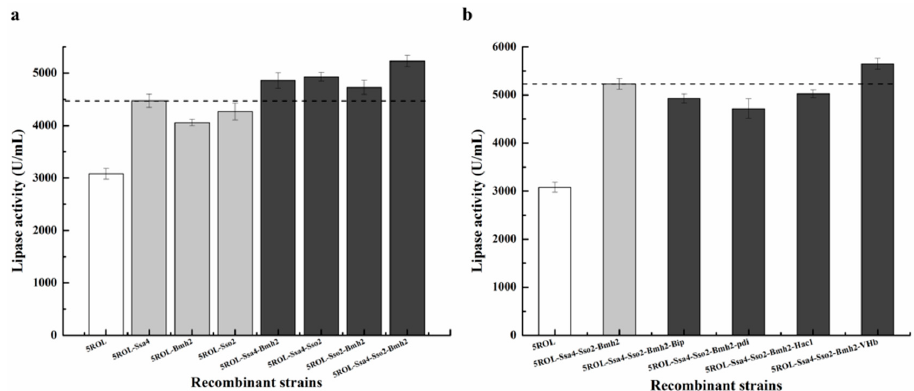
Figure 3. Cultivation properties of the recombinant strains in shaking flasks. ( a ) Effect of co-expressing multiple trafficking-related genes on ROL production in the strain GS115/pAO α -5ROL 11#. The dotted line indicates the lipase activity of the strain GS115/5ROL-Ssa4 12#. ( b ) Effect of co-expressing the helper proteins Bip, Pdi, Hac1, and VHb on ROL production in the strain GS115/5ROL-Ssa4-Sso2-Bmh2 4#. The dotted line indicates the lipase activity of the strain GS115/5ROL-Ssa4-Sso2-Bmh2 4#. Data represent the mean ± standard deviation of three independent